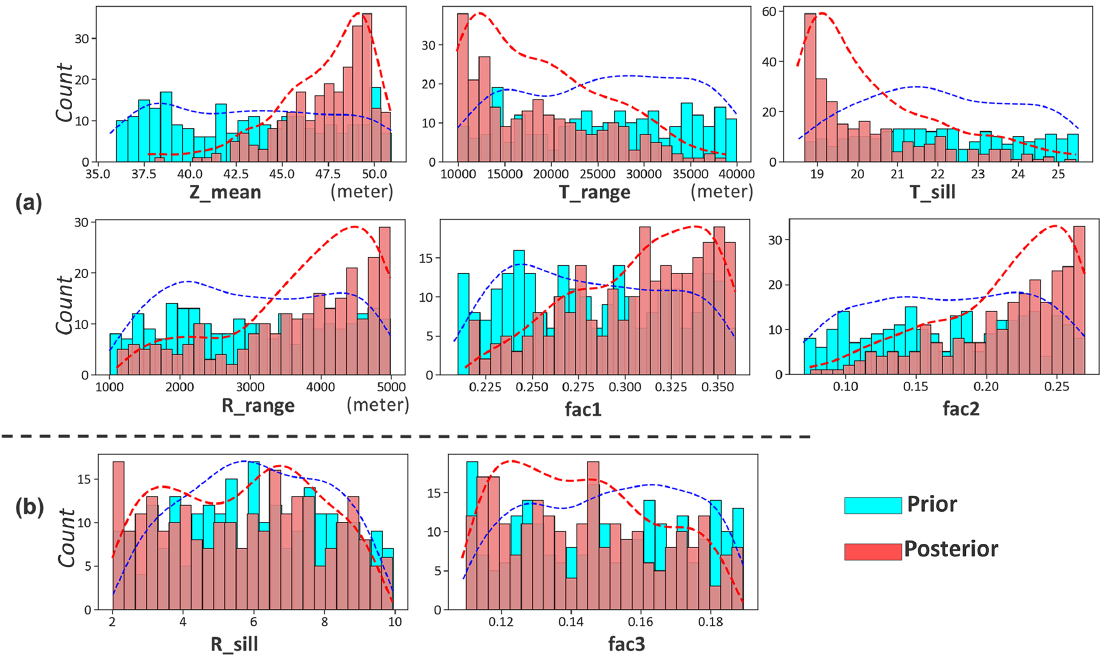
Figure 11. Uncertainty updating of (a) sensitive and (b) non-sensitive global model parameters at the first sequence. The dashed lines are estimated kernel density with Gaussian kernels.